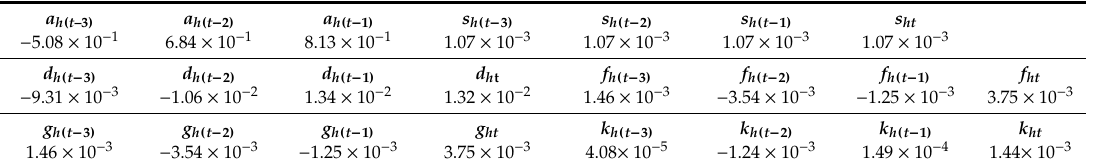
Table 1. Coe ffi cients for the inverse transfer function (ITF) model (1) that were experimentally obtained in